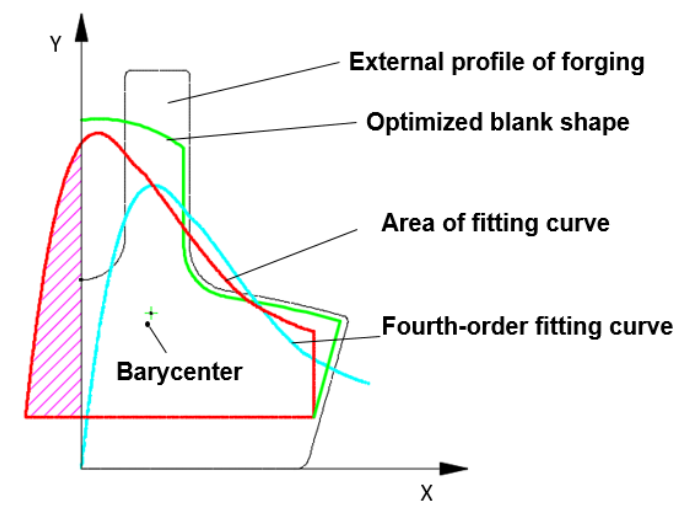
Figure 11. Contour line optimization of pre-formed blank.